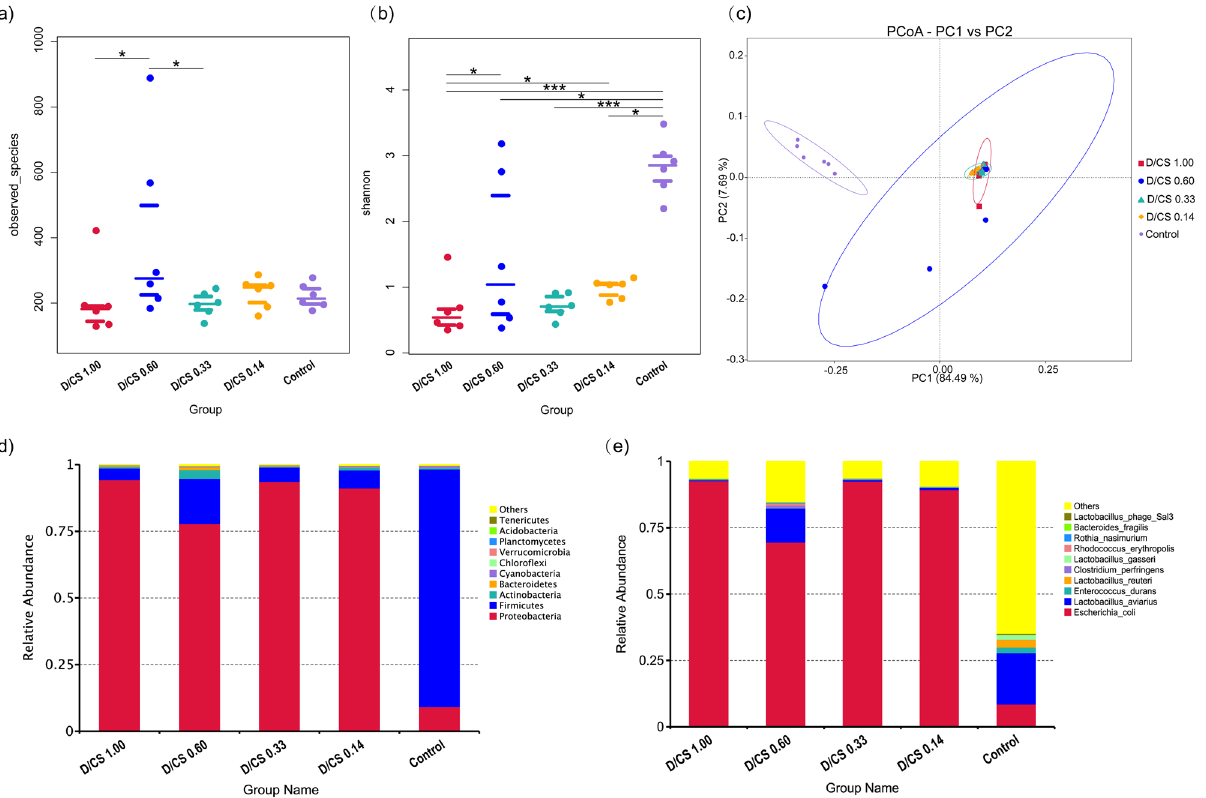
Figure 3. ( a ) Beeswarm of observed species in the ileal digesta among groups, representing the scatter distribution of the total number of species among different groups. ( b ) Beeswarm of Shannon index, reflecting the differences of species diversity and evenness among different groups. ( c ) Principal coordinates analysis (PCoA) of the microbial community. The analysis is generally based on the UniFrac distance, each point in the graph represents a sample, the distance between points represents the degree of difference, and the samples of the same group are represented by the same color. ( d )The relative abundance of top10 species at phylum level ( n = 6). ( e ) The relative abundance of top10 species at species level ( n =